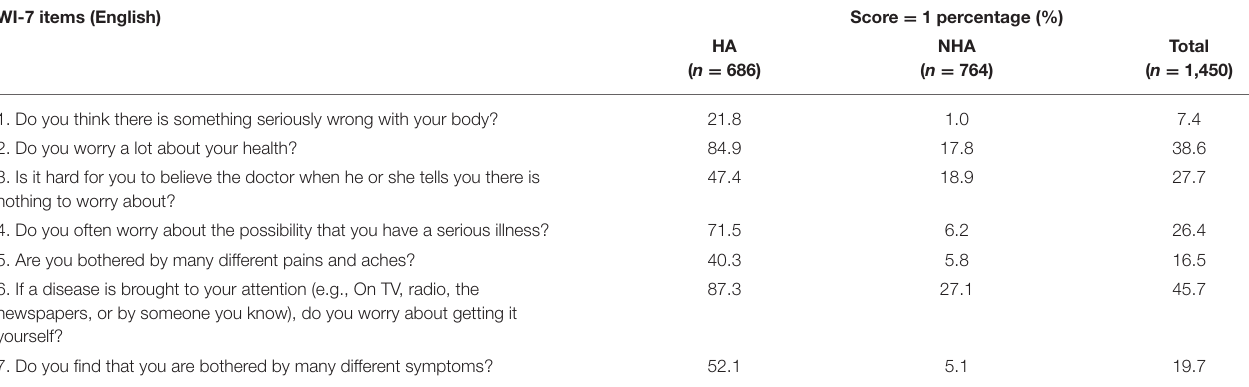
TABLE 2 | The frequency distribution of the 7-item Whiteley Index. WI-7 items